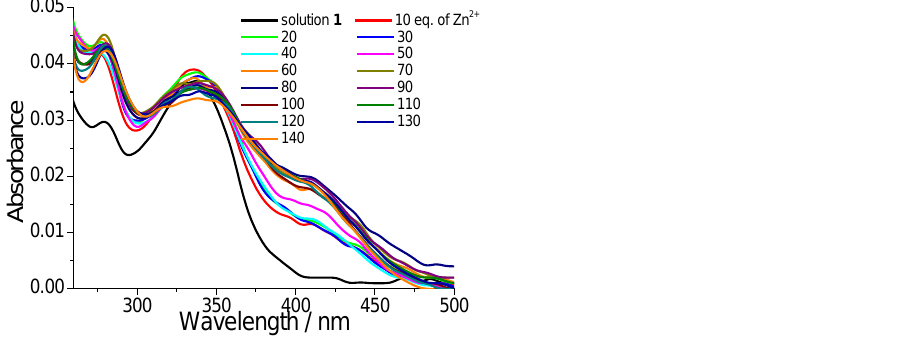
Figure 11. UV-vis absorption spectra change of solution 1 in 1,4-dioxane upon the titration of Zn 2+ .